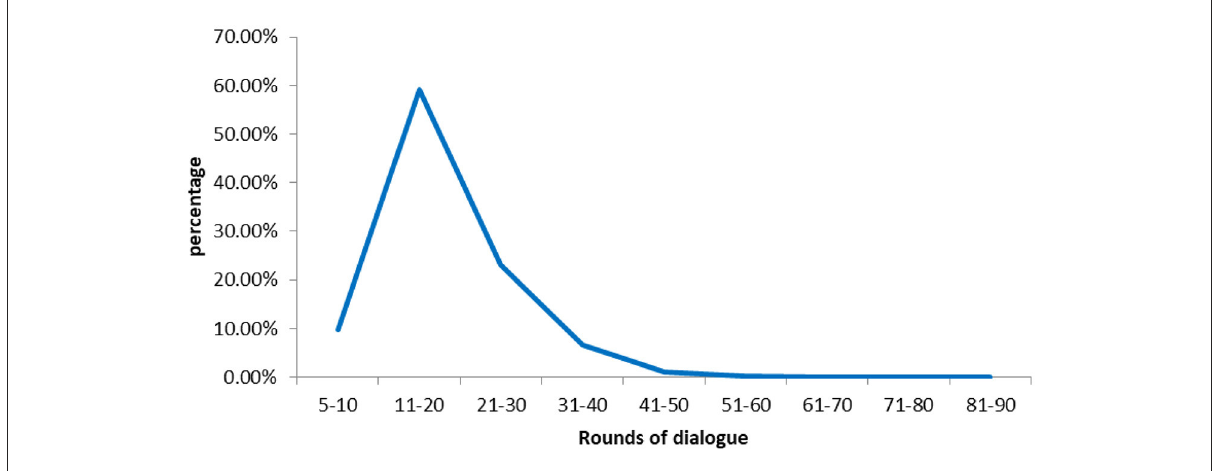
FIGURE6 Distribution of rounds of dialogue between physicians and users.